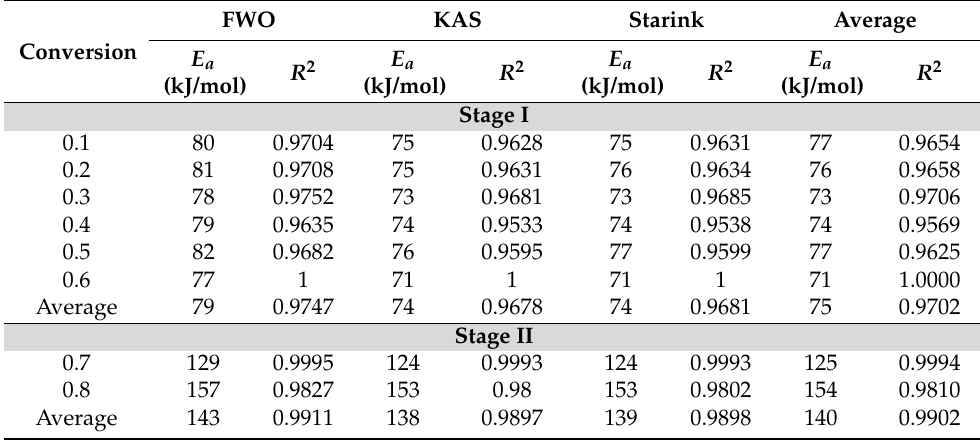
Figure 4. Regression lines of the experimental data of the PVC pyrolysis (stage II) by: ( a ) FWO, ( b ) KAS, and ( c ) Starink models. Table 5. Activation energy values obtained by isoconversional